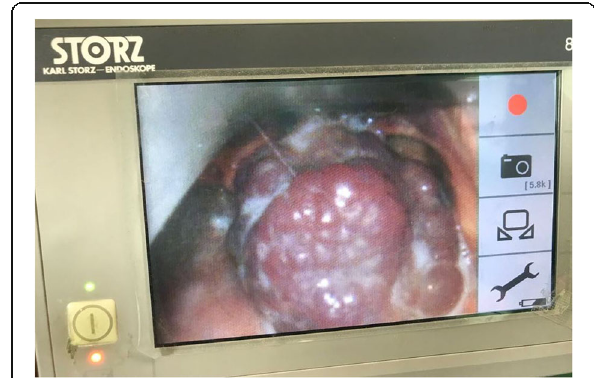
Fig. 1 C Mac D-blade videolaryngoscopic view of the friable hemangioma and glottis.